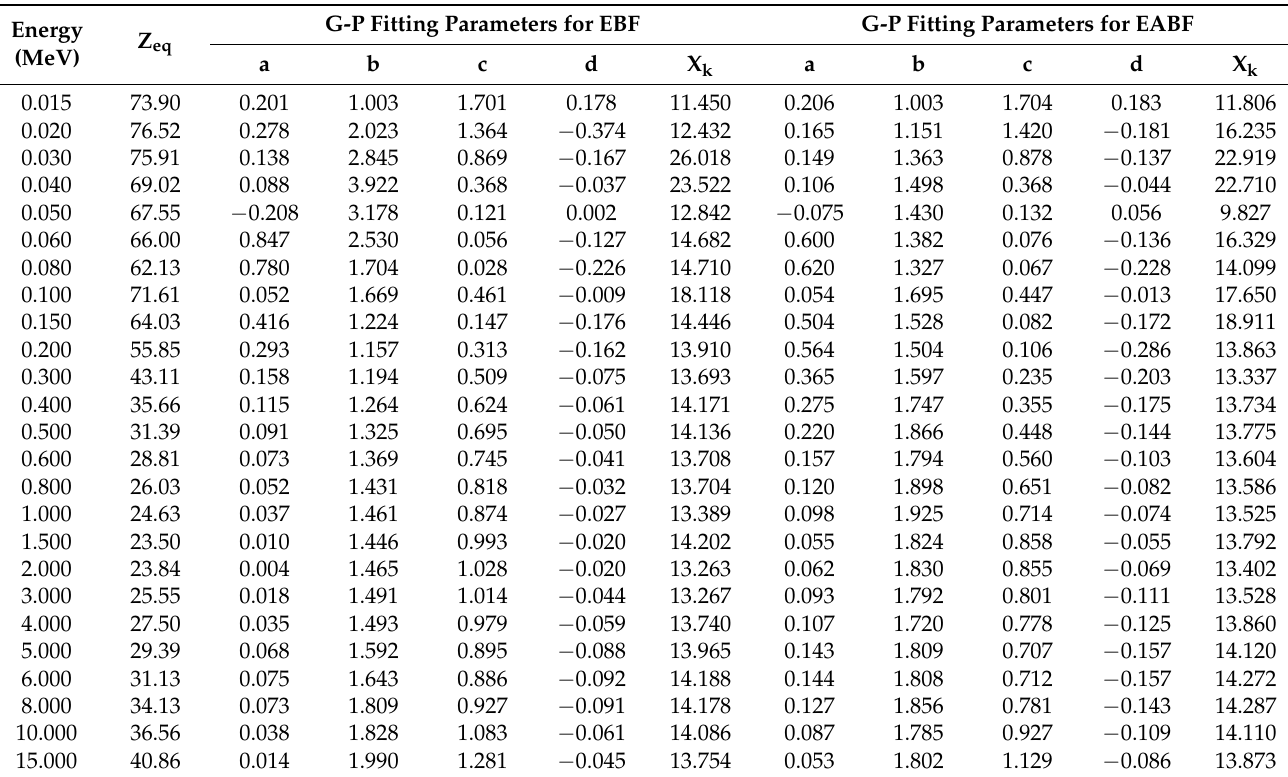
Table 5. (EBF and EABF) G–P fitting coefficients (b, c, a, Xk and d) of LPb50Eu1 glass sample.